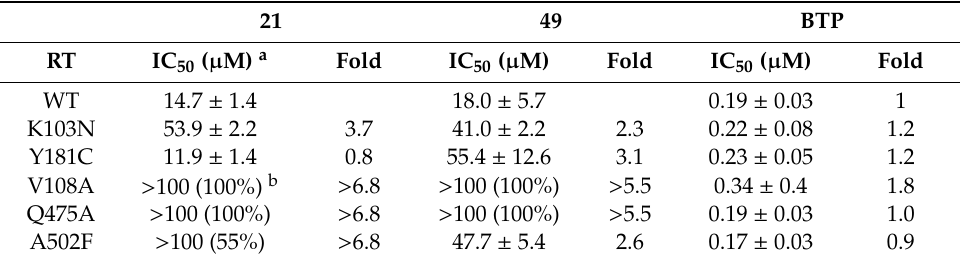
Table 4. Inhibition of HIV-1 RNase H activity of mutated HIV-1